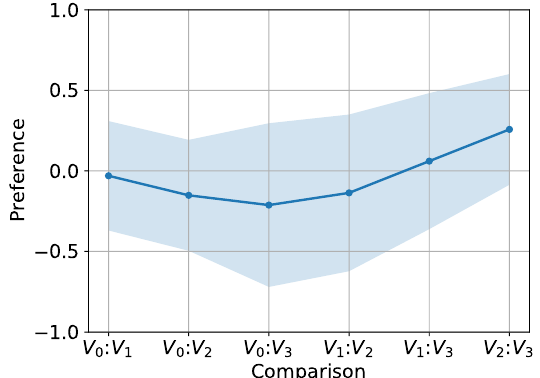
Figure 2. Analysis of the preference ratings (“better” (1), “worse” ( − 1), or “similar” (0)) of the vibration levels across all parts and all participants. The ratings are based on direct comparisons between all pairs of levels. The ratings are relative. For example, a positive value for V 0 : V 1 indicates a preference of V 0 over V 1 and a negative value a preference of V 1 over V 0 . The shaded area marks the standard deviation of the